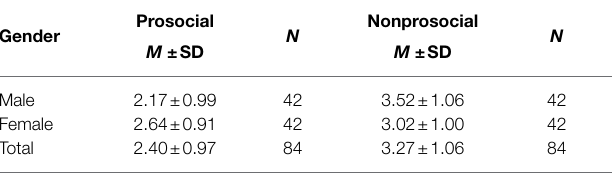
TABLE 3 | Means and standard deviation of post-tested aggressive